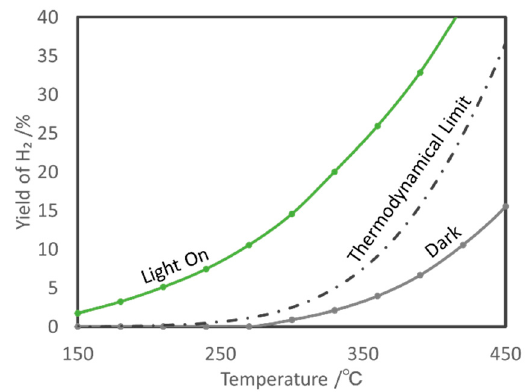
Figure 27. Catalytic activity under dark conditions, photocatalytic activity under visible light irradiated conditions, and thermodynamical limit calculated using the equilibrium [7]. Reproduced from [22] with permission from The Royal Society of Chemistry.